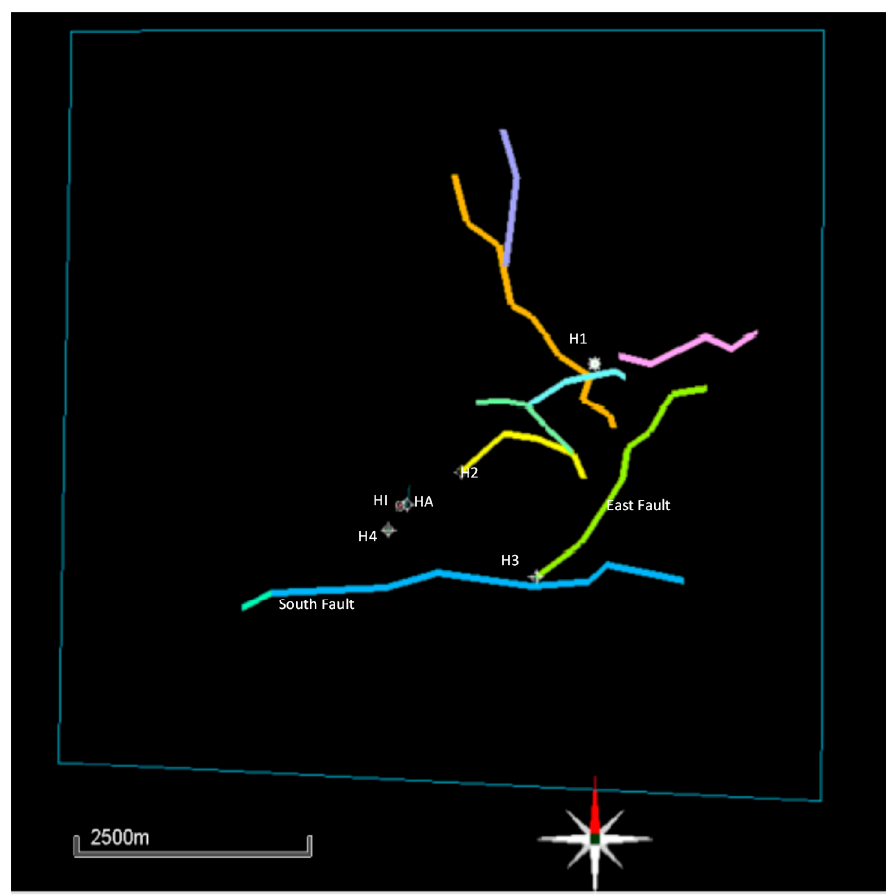
Figure 1. Hontomín geological model extension. The South fault, i.e., Ubierna fault (in dark blue), and East fault (in light green) control the structural south-eastward extension of the storage formation.